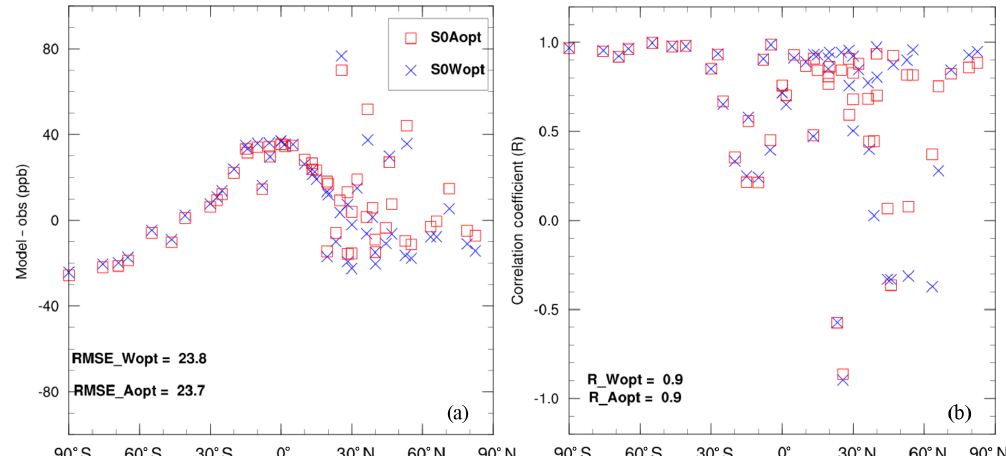
Figure 2. Model bias (a) and correlation coefficient (b) of simulated climatological mean surface methane concentrations against NOAA GMD observations for the 1983–2017 time period. GMD sites with at least 20-year observations are selected for model climatological evaluation. In panel (a) , each red square or blue “X” represents model mean bias by S0Aopt or S0Wopt at the corresponding GMD site. Root-mean-square error (RMSE) is shown for all the GMD sites in panel (a) . In panel (b) , each red square or blue “X” represents correlation of climatological seasonal variability by S0Aopt or S0Wopt at the corresponding GMD site. Spatial correlation ( R ) is shown for all the GMD sites in panel (b)